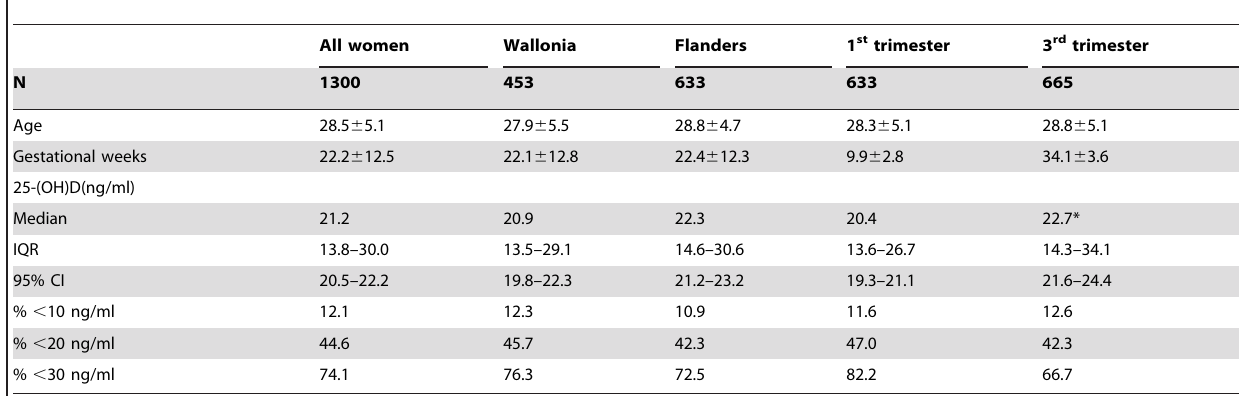
Table 3. Serum 25-(OH)D concentration in pregnant women (n= 1311) (Belgian national survey on vitamin D status in pregnant women, 2010–2011).